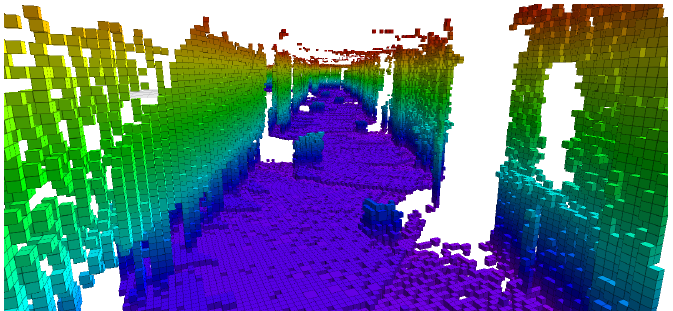
Figure 15. Octomap of the point cloud map shown in Figure 14b.